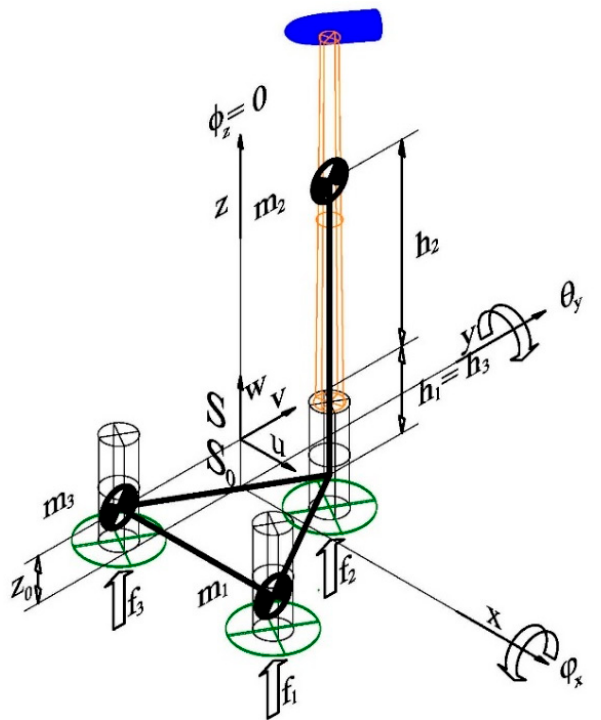
Figure 6. Reference frames and main magnitudes.